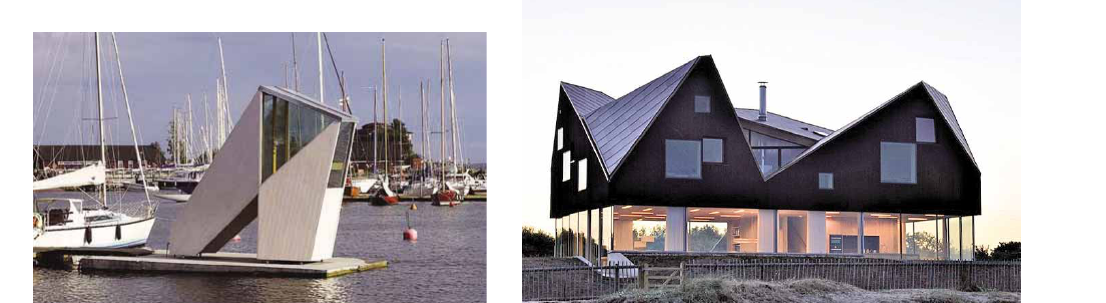
Fig. 26. Observation building in Helsinki,